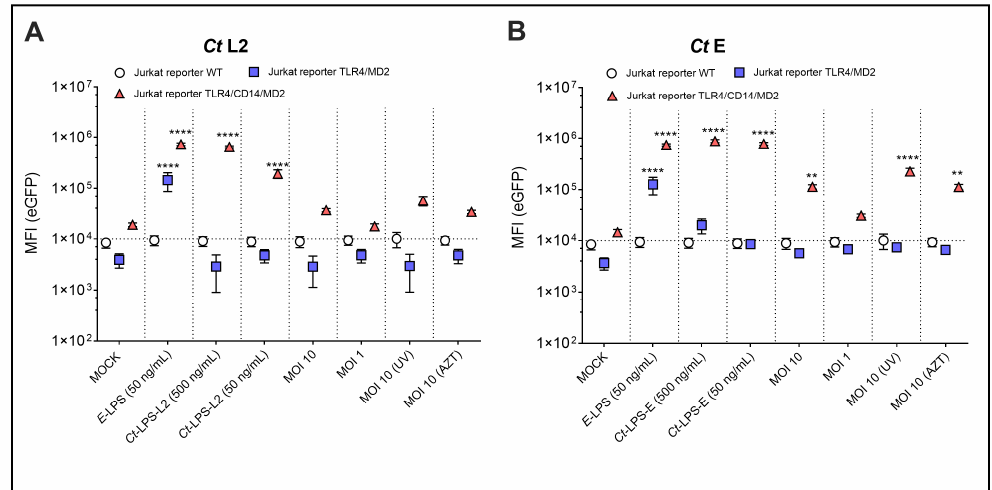
Figure 3. NF- κ B dependent expression of eGFP upon incubation of different Jurkat reporter cells with various LPS- and Ct -preparations. WT, TLR4/MD2 or TLR4/CD14/MD2 Jurkat reporter cells after 20 h of incubation with Ct serovar L2 ( A ) or serovar E ( B ), E-LPS– E. coli derived LPS, Ct -LPS-L2– Ct serovar L2 derived LPS, Ct -LPS-E– Ct serovar E derived LPS, MOI 10 (UV)–UV-treated Ct with MOI 10, MOI 10 (AZT)–AZT-treated Ct with MOI 10. The data represent eGFP-MFI means ± SEM of three independent experiments. Statistical differences were assessed by 2way ANOVA followed by Dunnett’s multiple comparisons test. ** P < 0.01, **** P < 0.0001. Only statistically significant differences between conditions are indicated. Error bars represent mean ± SEM.